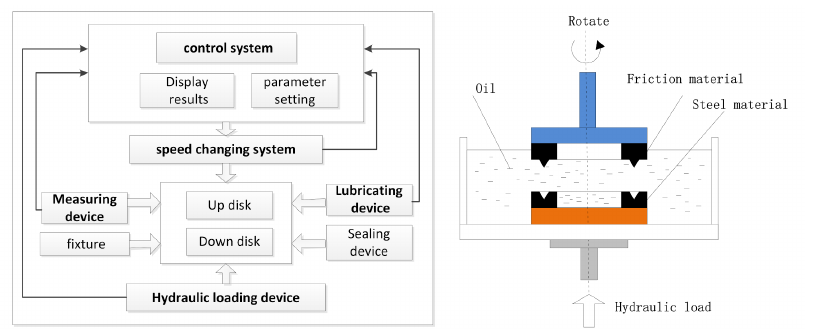
Figure 4. Schematic diagram of the friction test